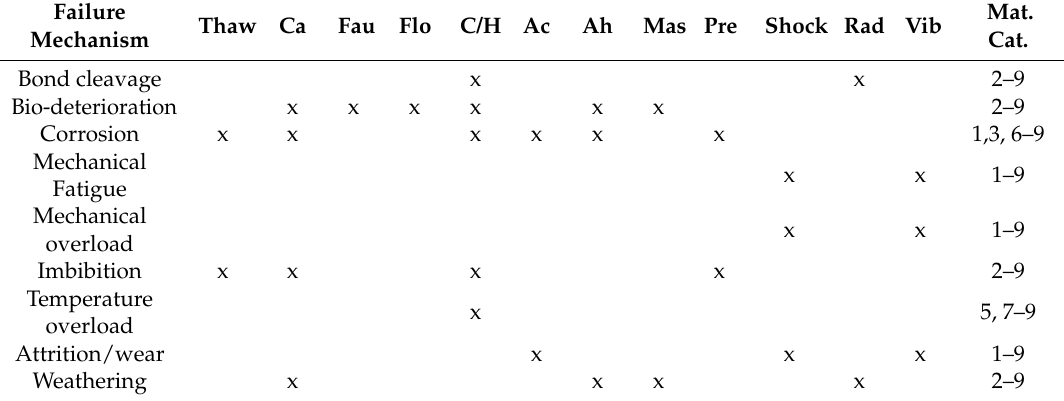
Environmentally caused failure mechanisms in automotive transport